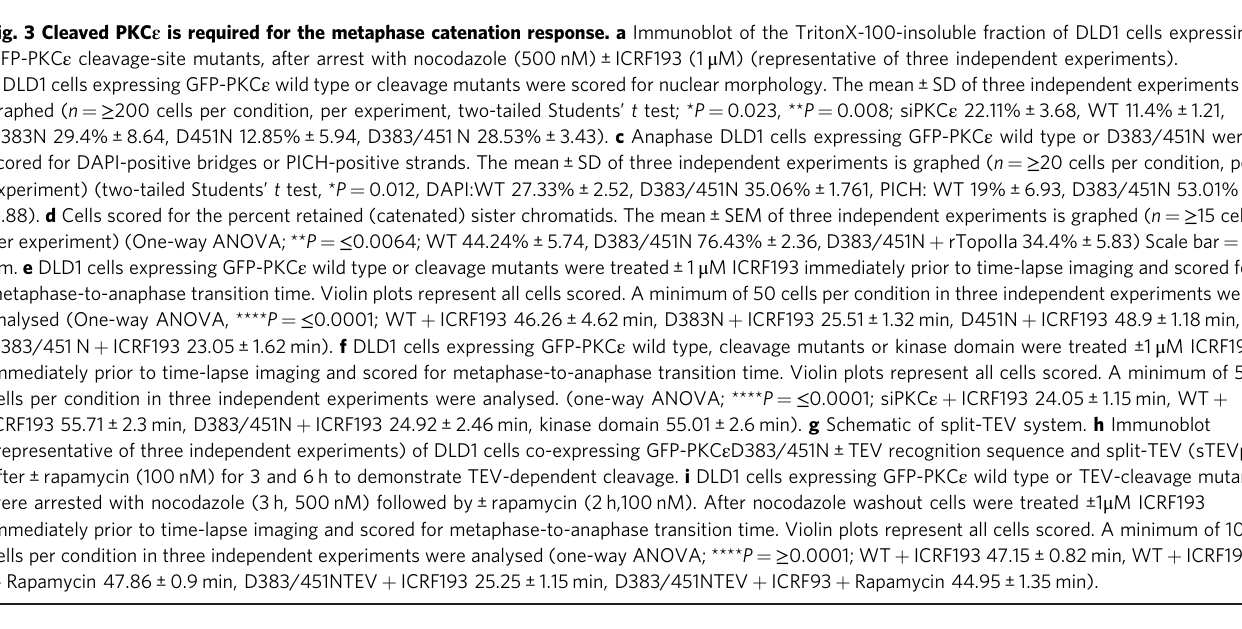
Fig. 3 Cleaved PKC ε is required for the metaphase catenation response. a Immunoblot of the TritonX-100-insoluble fraction of DLD1 cells expressing GFP-PKC ε cleavage-site mutants, after arrest with nocodazole (500 nM) ± ICRF193 (1 μ M) (representative of three independent experiments). b DLD1 cells expressing GFP-PKC ε wild type or cleavage mutants were scored for nuclear morphology. The mean ± SD of three independent experiments is graphed ( n = ≥ 200 cells per condition, per experiment, two-tailed Students ’ t test; * P = 0.023, ** P = 0.008; siPKC ε 22.11% ± 3.68, WT 11.4% ±